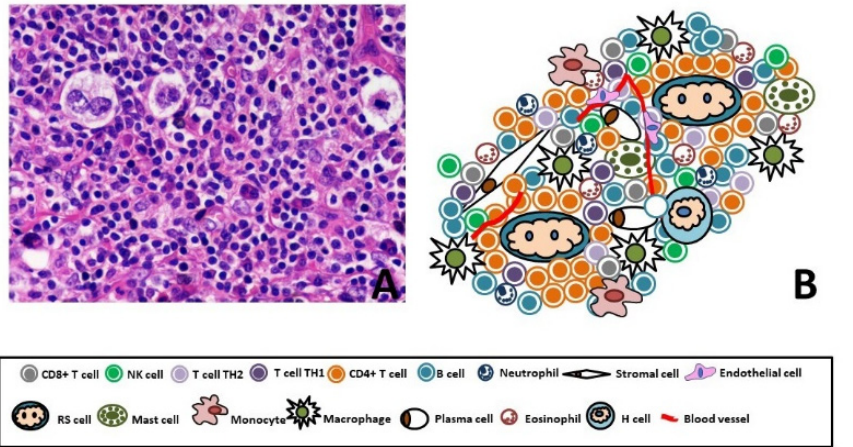
Figure 1. A . Representative figure of Hodgkin Lymphoma (40X, Hematoxylin Eosin). B . Cartoon of Hodgkin Lymphoma, few RS and H cells (1–10%) immerse in a special microenvironment. The 90% of the tumor mass is composed by CD4 + Th cells, CD4 + Tregs, CD8 T cells, B lymphocytes, plasma cells, histiocytes/macrophages, granulocytes, eosinophils, mast cells, MSCs and endothelial cells.